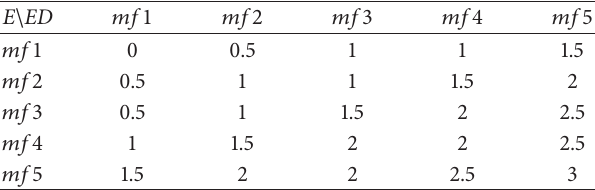
Table 2: Rules for 𝐾 𝐼